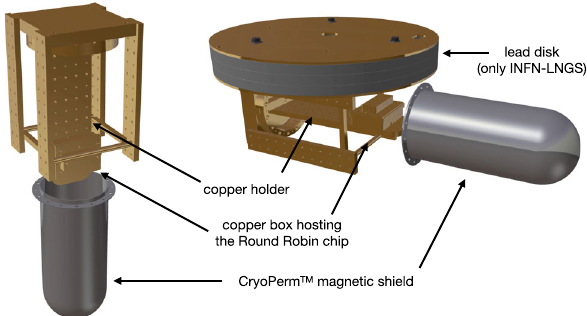
Fig. 2 Left: holder of the Round Robin chip. The copper box host- ing the Round Robin chip, mounted on a gold-plated copper holder, is surrounded by a CryoPerm® magnetic shield. Gold-plated copper bars allow the installation of “cold” electronics components (not shown in the picture) in the proximity of the sample. The square copper element can be mounted on the bottom of the mixing chamber plate (the coldest point of the dilution refrigerator). Right: installation in INFN-LNGS, where the DU experimental space prevents the vertical configuration.